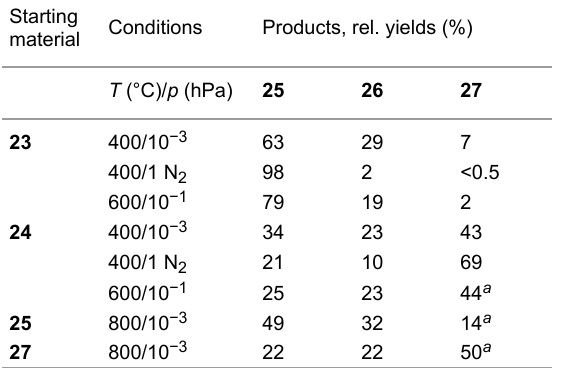
Table 1: Dimethylcyanopyrroles from